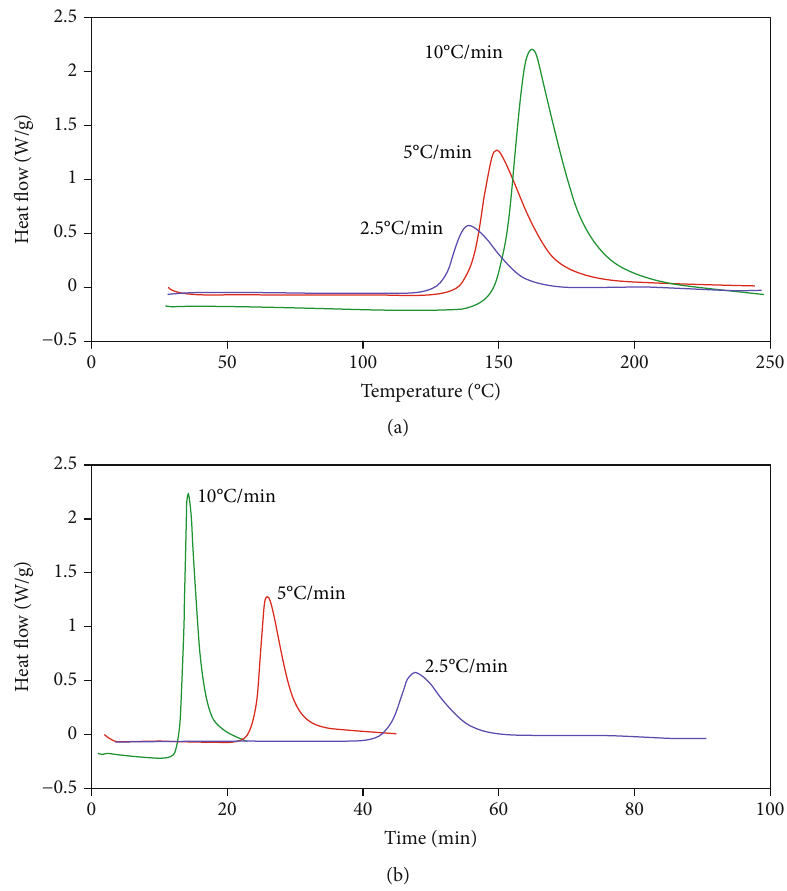
Figure 9: The heating fl ow rates versus (a) temperature and (b) time for uncured EP-PEG-NS.